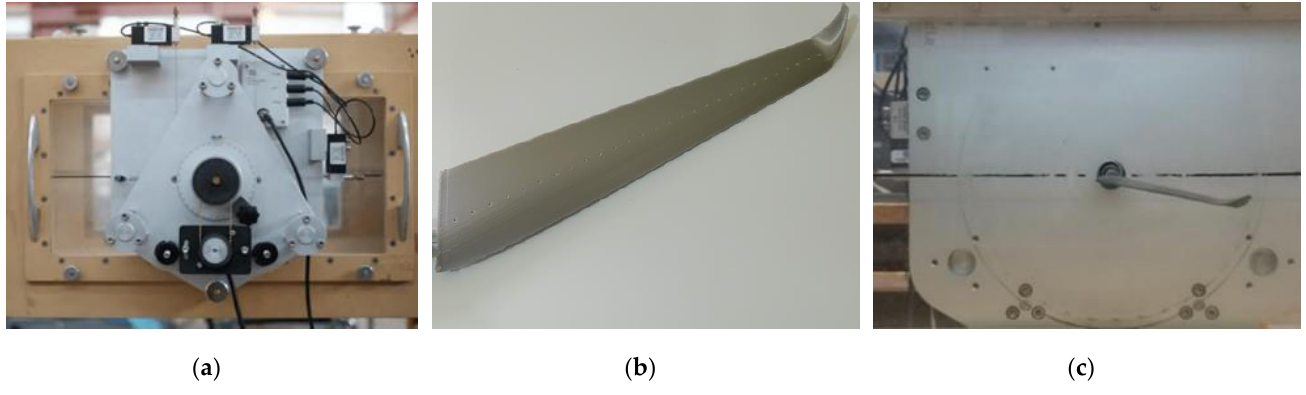
Figure 8. ( a ) The three-component AFA3 aerodynamic balance, ( b ) the manufactured wing with the dimples at 40% of the chord, and ( c ) the wing mounted in the measurement chamber of the wind- tunnel.